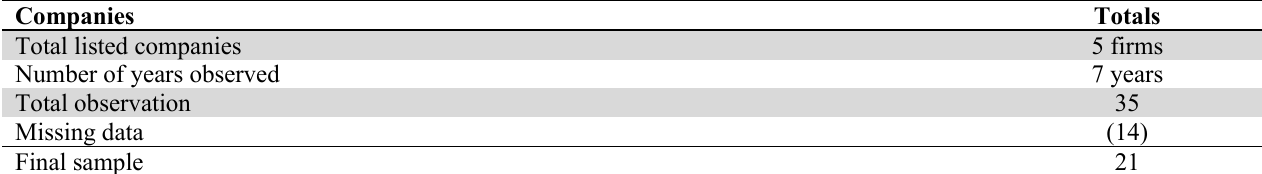
Sample Selection from 2013 to